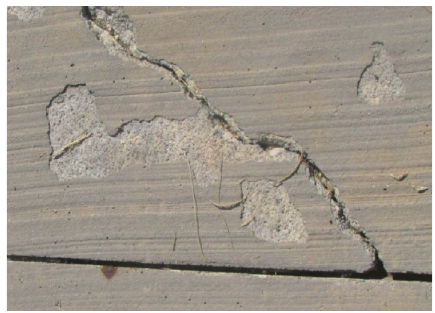
Figure 3: Scaling [12].